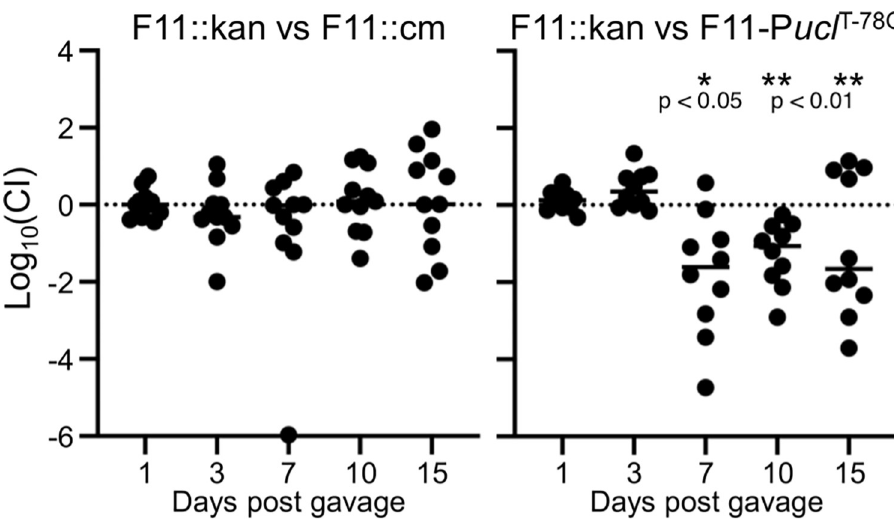
Fig 3. Increased Ucl fimbriae expression enhances mouse gut colonisation. Mice were inoculated with a 1:1 mixture of F11::kan vs F11::cm (control) or F11::kan vs F11-P ucl T-78G (cm resistant). Each group contained 10–11 mice infected and monitored during two independent experiments. Differential resistance markers were used to determine bacterial loads and a competitive index was calculated for each mouse at each time point. Wilcoxon Signed Rank tests were performed on each group for each time point; � P < 0.05, �� P <